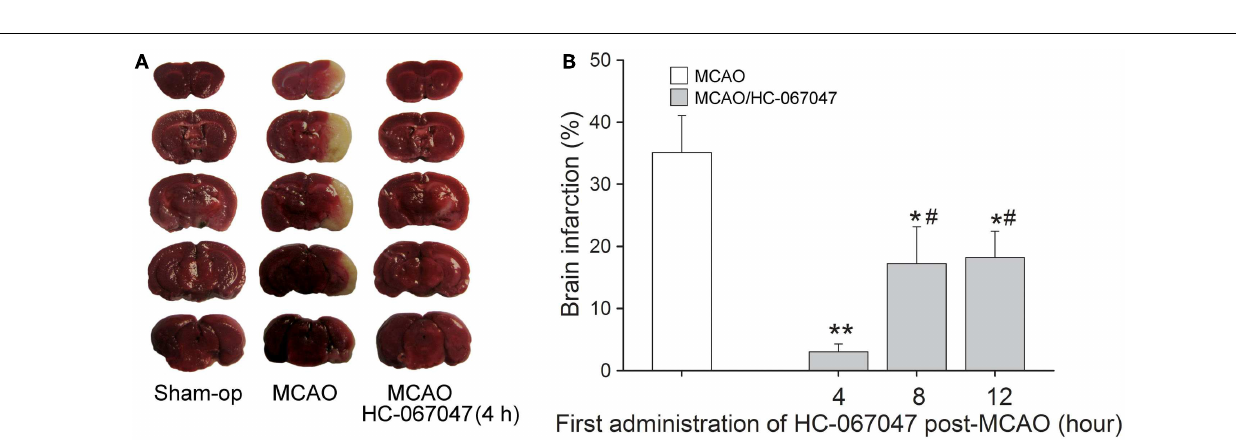
FIGURE 6 |TRPV4 antagonist reduces brain damage after focal cerebral ischemia. (A) Representative photographs of cerebral infarction in MCAO mice treated with HC-067047. Note that treatment with HC-067047 (HC-4h) after stroke significantly reduced the MCAO-induced cerebral infarction. (B)